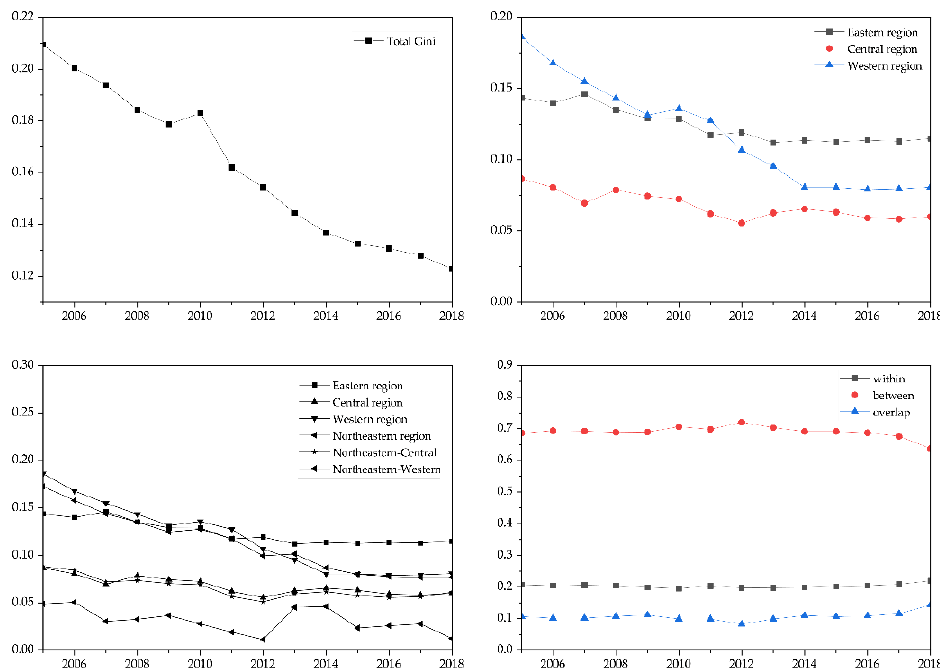
Figure 3. Spatial and temporal evolution trend of DVI in China.